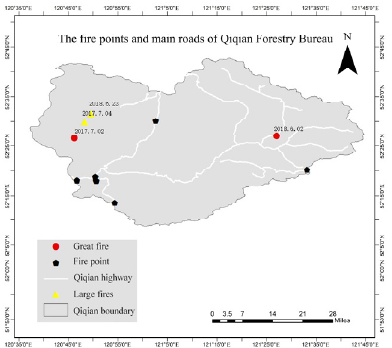
Figure 1. The fire points and main roads of Qiqian Forestry Bureau.